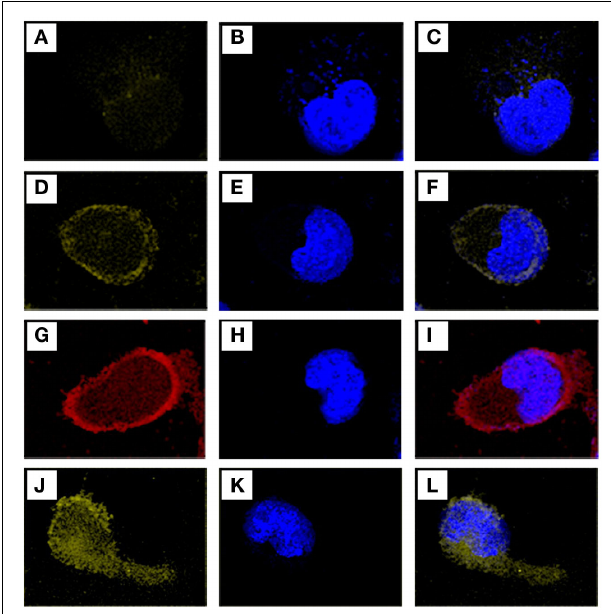
FIGURE 3 | Confocal laser scanning microscope images of fluorescent human histamine H 3 ligands on HEK-293 cells and hH 3 -HEK-293. All images were taken on a LeicaTCS SP5 microscope. Fluorescent chalcones were incubated for 1h and after washing steps nuclei were stained with blue fluorescent DAPI. (A) Shows a HEK-293 cell labeled with compound 3 and (B) shows the DAPI-stained nucleus of the same cell. (C) Is an overlay of image (A,B) . (D) Shows compound 3 on an hH 3 -HEK-293 cell, (E) the DAPI-stained nucleus of the same cell and (F) an overlay of (D) and (E) . Red fluorescent compound 5 on an hH 3 -HEK-293 cell is shown in (G) , cell nucleus in (H) , and the overlay of (G) and (H) in (I) . (J) Shows an hH 3 -HEK-293 cell stained with compound 9 , (K) its nucleus, and (L) the overlay of (J,K)